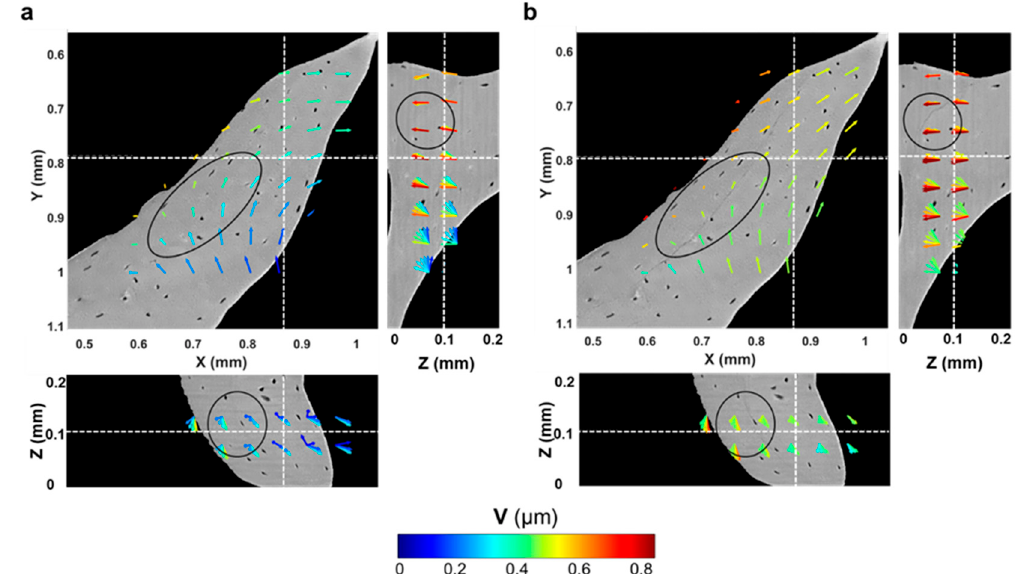
Figure 8. DVC-computed displacement field through the region of interest analysed around the microcracked area ( a ) before (fourth tomogram) and ( b ) after cracking was visible (fifth tomogram). Oval regions highlight damaged areas of bone tissue. Vector lengths are identical, and the colour code refers to the displacement vector length (V) in micrometres.